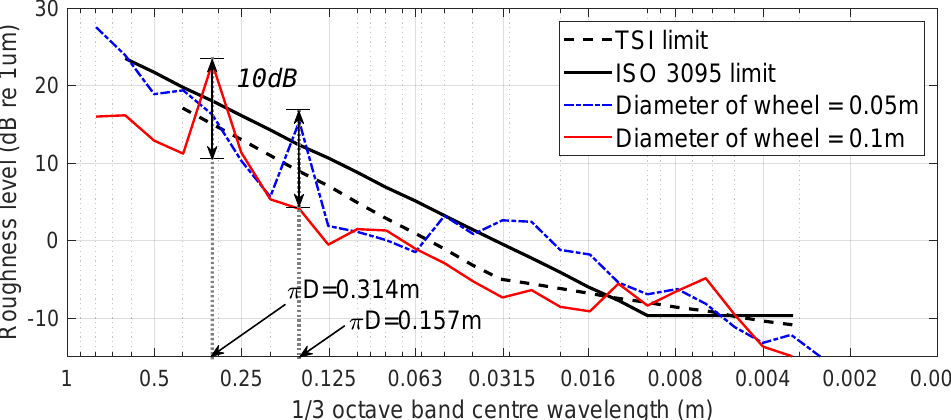
Figure 10. Amplified roughness level according to wheel diameter (TSI: Technical Specification for Interoperability).